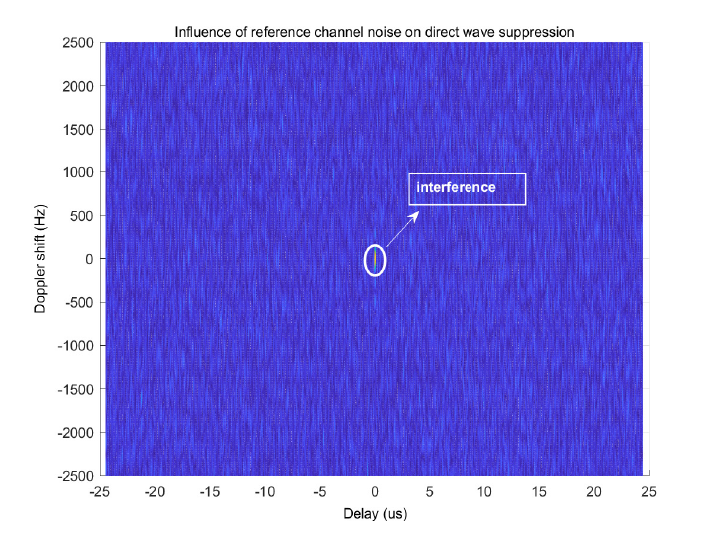
Figure 4. The influence of reference channel SNR on interference suppression process with SNR = − 15 dB.